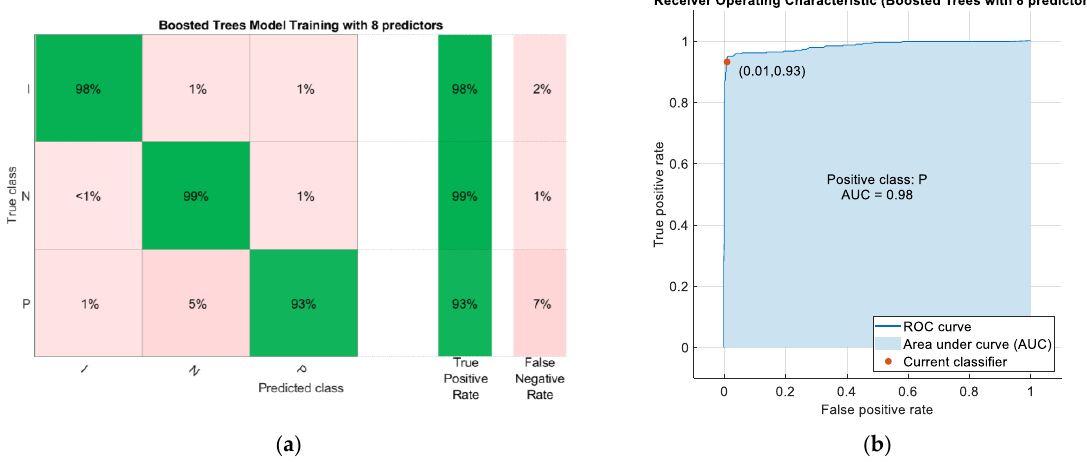
Figure 9. ( a ) Confusion matrix of the Boosted Trees model after training using the 8 predictors with the highest weights after applying the NCA algorithm; ( b ) Receiver Operating Characteristic (ROC) curve and its respective area under the curve (AUC).